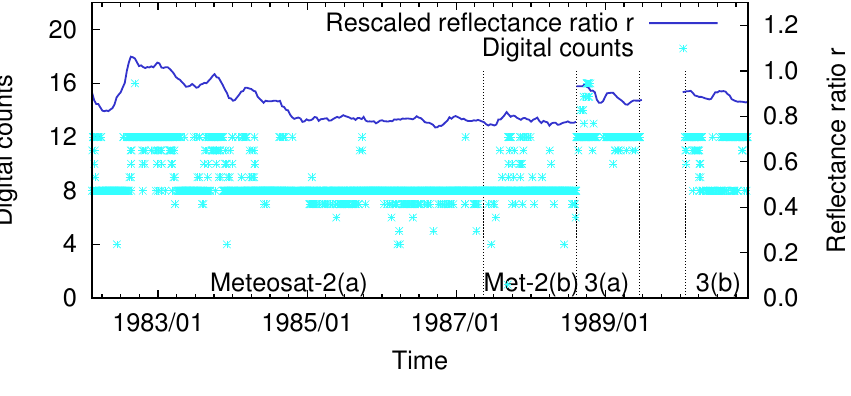
Figure 4. 55 ocean targets for Meteosat-2 and -3. The light blue crosses are the daily minimum values of the 55 targets (left y-axis). The dark blue full line is the reflectance ratio curve of Figure 2 (right